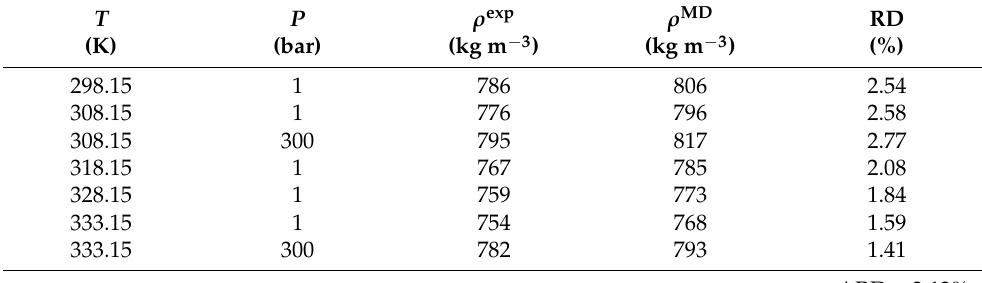
Table 4. Ethanol’s experimental ( ρ exp ) and computed ( ρ MD ) density and respective relative deviation (RD). The computer simulations used σ OH = 0.306 nm for